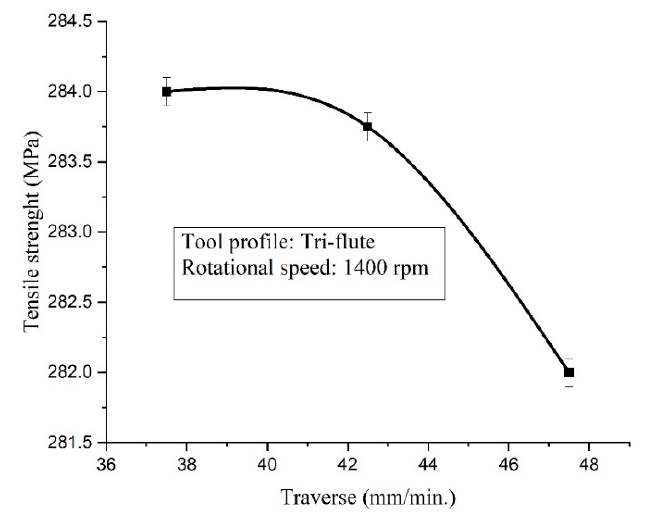
Figure 14. Influence of traverse speed on tensile strength.